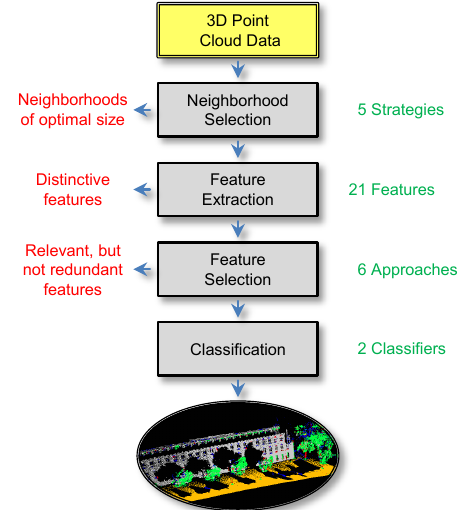
Figure 2: The proposed framework: the contributions are high- lighted in red, and the quantity of attributes/approaches used for evaluation is indicated in